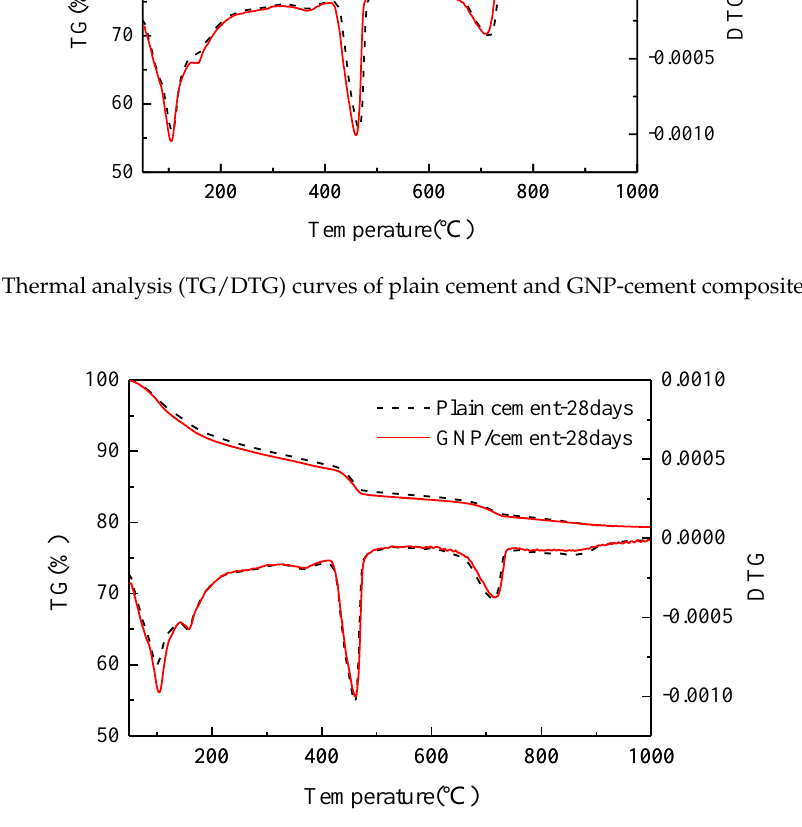
Figure 8. TG/DTG curves of plain cement and GNP-cement composite at the age of 28 days.